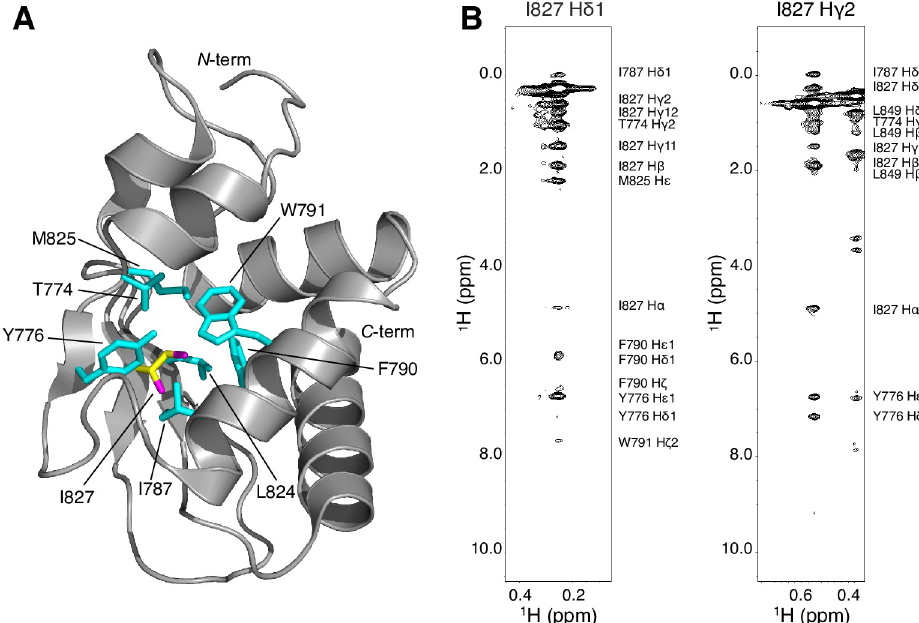
Fig 4. The I827 residue is an integral residue in the hydrophobic core of E6AP C-lobe . (A) The E6AP structure (PDB 1D5F) was rendered in Pymol highlighting the I827 residue (yellow with magenta methyls) surrounded by several aromatic and hydrophobic residues (cyan). (B) Representative 1 H- 1 H-NOE strip plots for the I827 methyls showing numerous strong contacts with the surrounding hydrophobic atoms of core residues including T774, Y776, I787, F790, W791, L824, M825, and I827. The authenticity of the assignment was confirmed by reciprocal NOEs from the identified atoms.